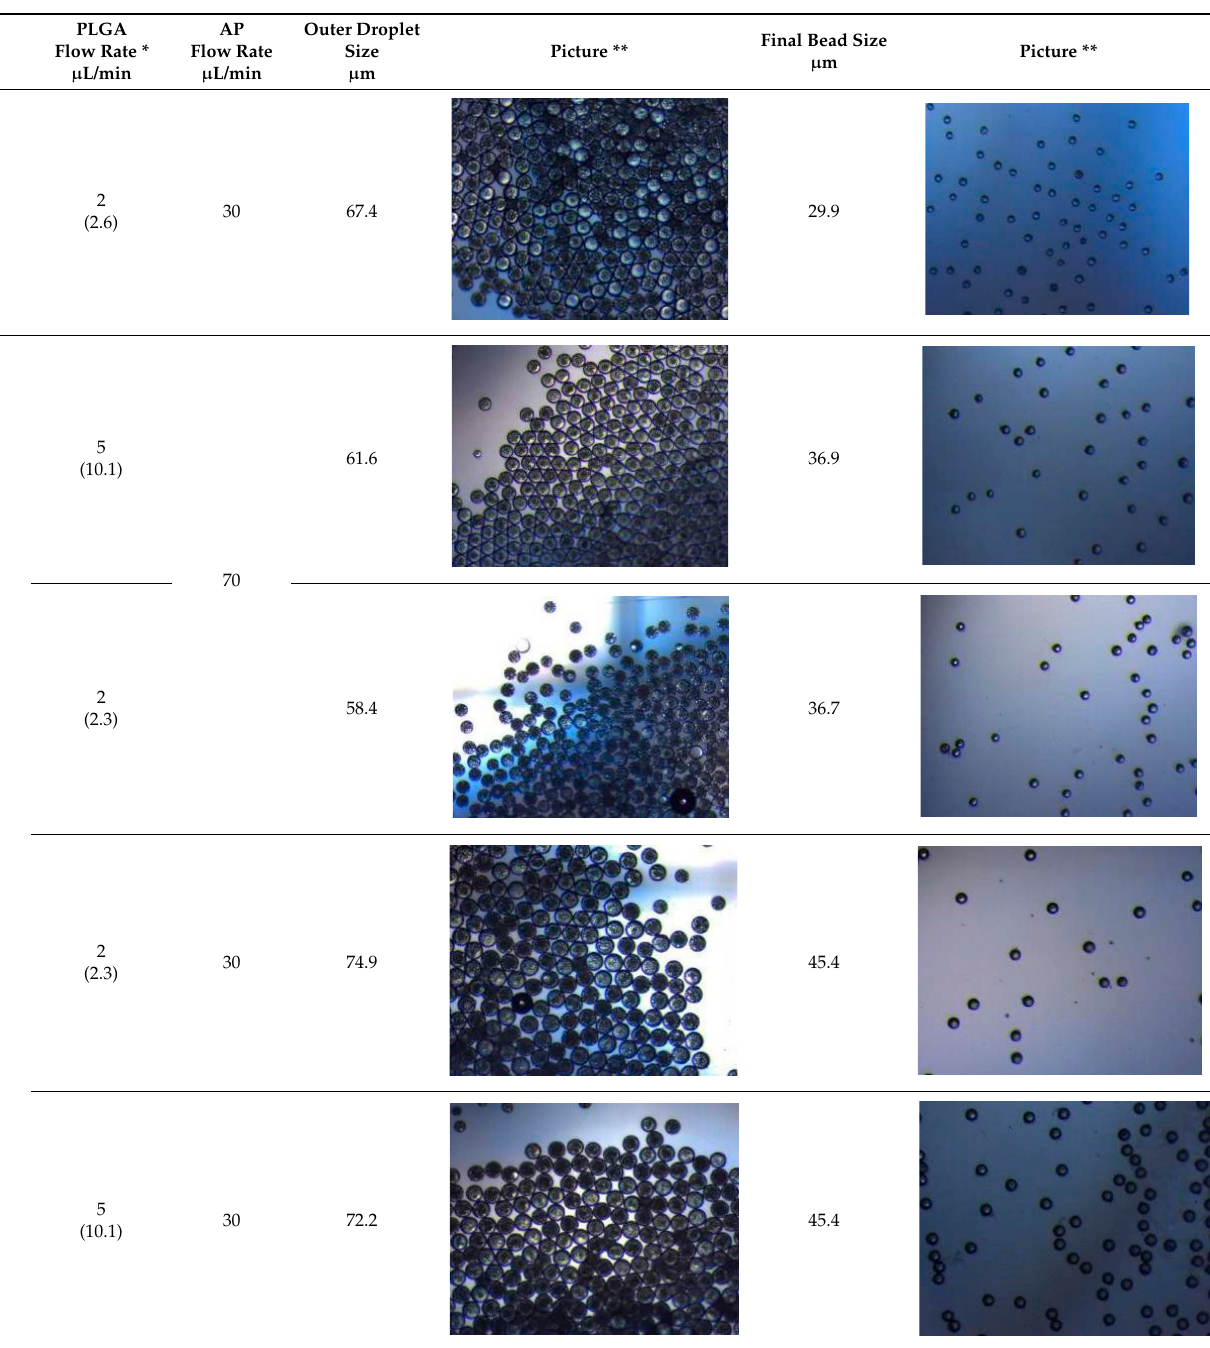
Table 2. Flow/MP size/polymer concentration relationship. (https://microtas2020.org/images/cur- rent_support_files/dolomite/Dolomite_Application_Note-Microfluidic_Produc- tion_of_20_to_50_%C2%B5m_Core-Shell_PLGA_Beads.pdf accessed on 30 September 2019). PLGA wt % PLGA Flow Rate * ul/min